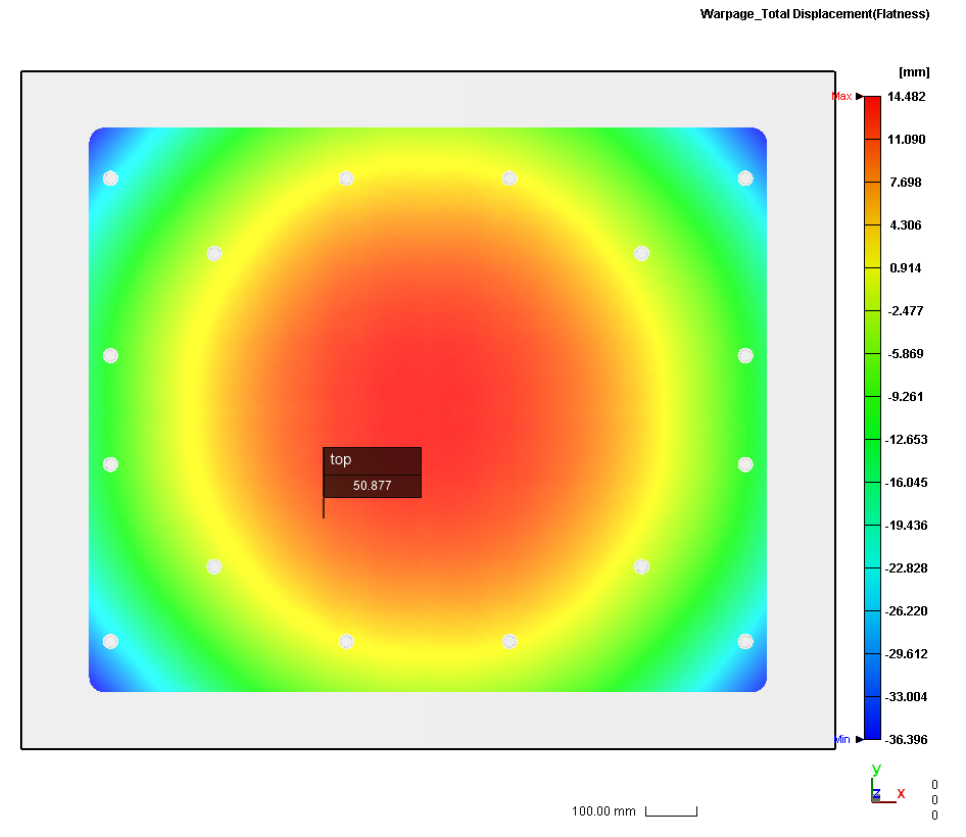
Figure 4. Top view of the numerically simulated total warpage of the HDPE half-pallet by ICM.